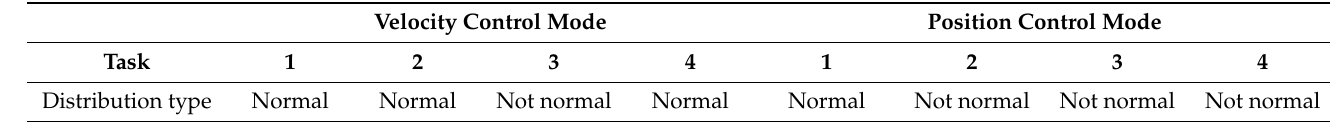
Table A3. Active 2R spherical mechanism-based joint sample distributions.